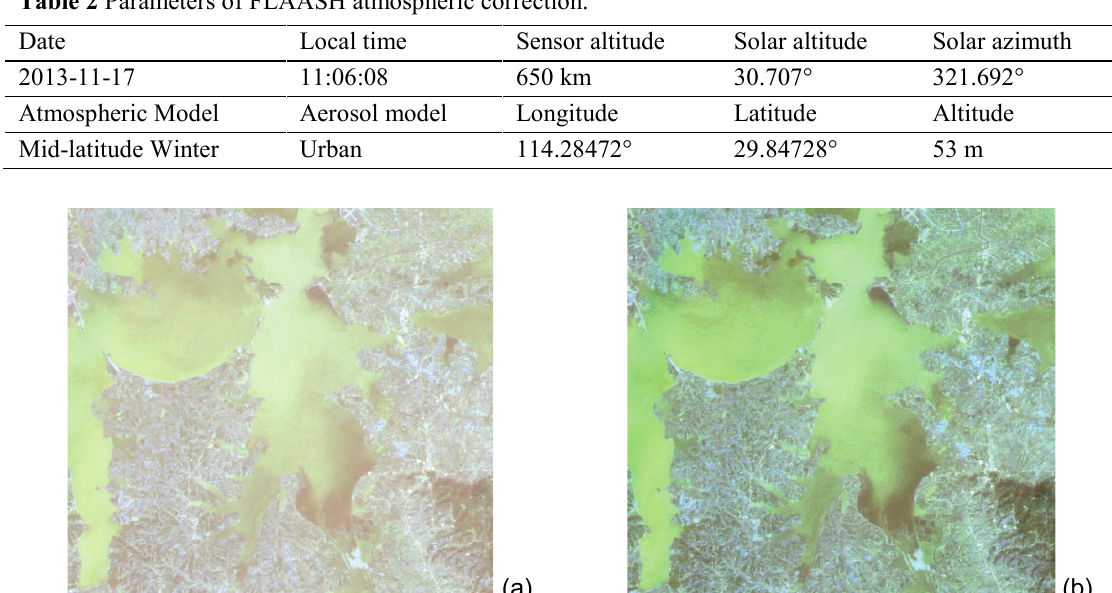
Fig. 2 Result of comparison of before and after FLAASH atmospheric correction; (a) before atmospheric correction, and (b) after atmospheric correction.